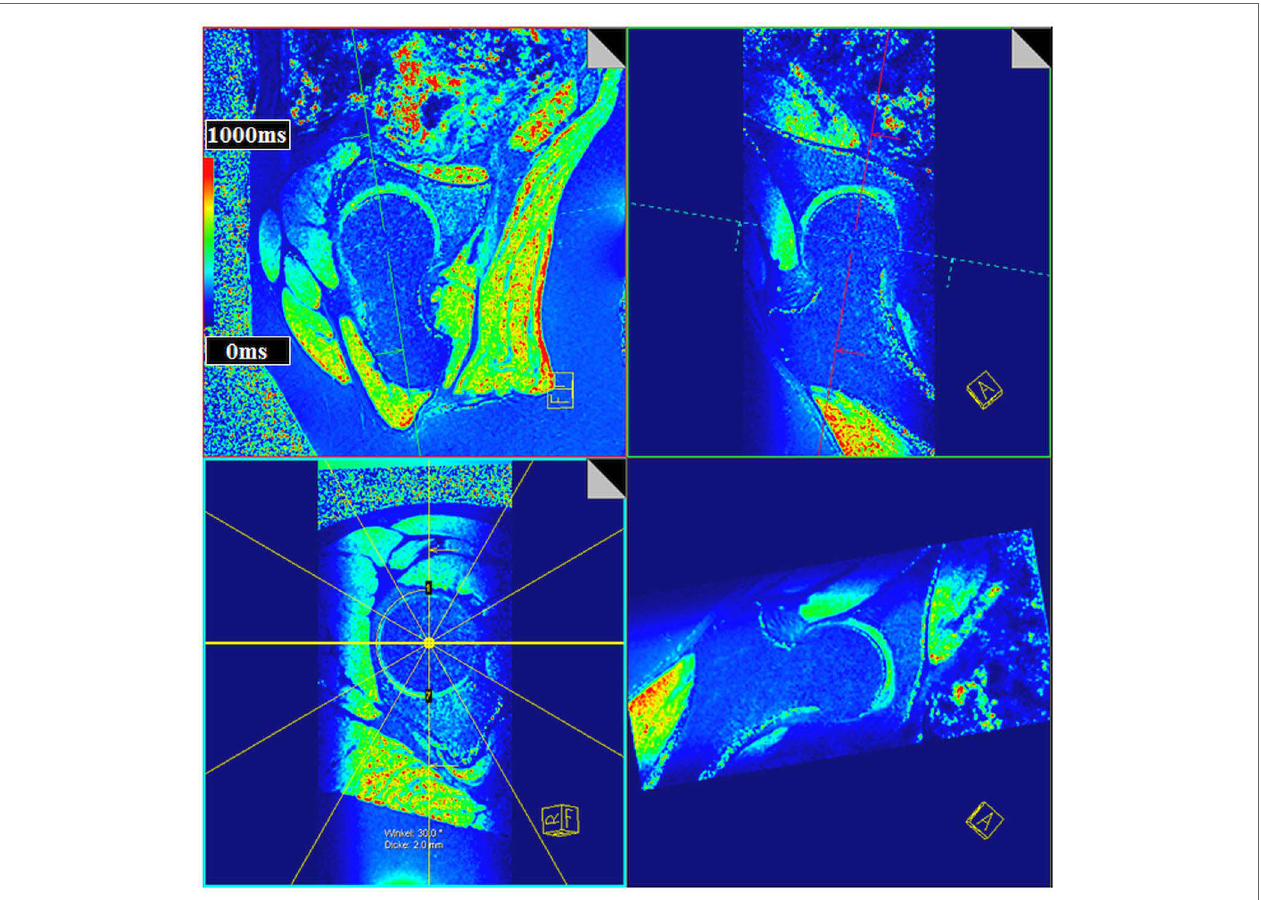
FiGURe 4 | Multi-planar-reconstruction of the three-dimensional (3D) T1 Gd data set including plane adjustment through the center of the femoral head and perpendicular to the femoral neck within the sagittal oblique view and the coronal oblique view to create radial T1 Gd planes